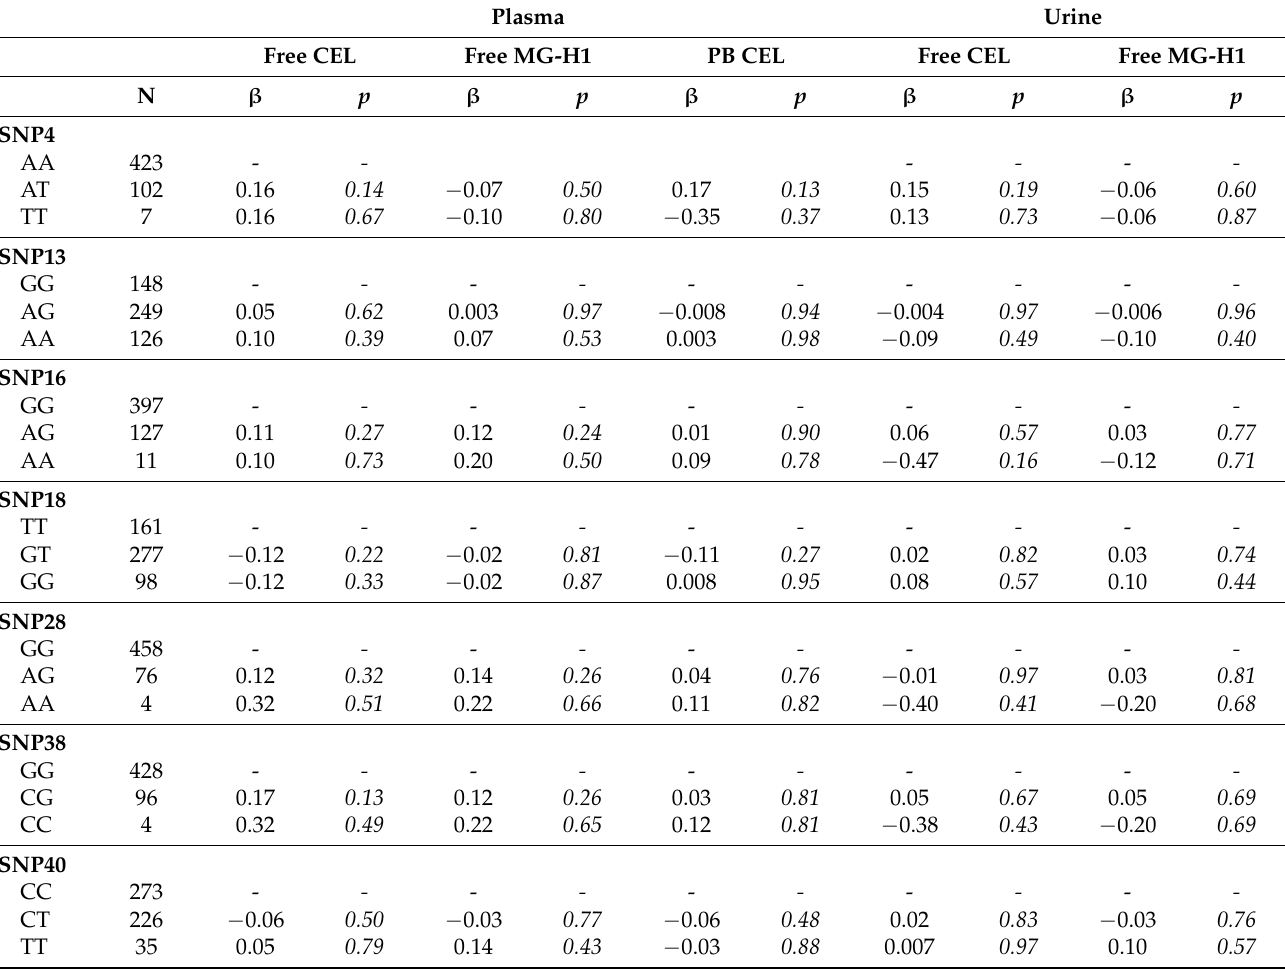
Table 3. Association of GLO1 SNPs with MGO-derived AGEs in plasma and urine 1 .